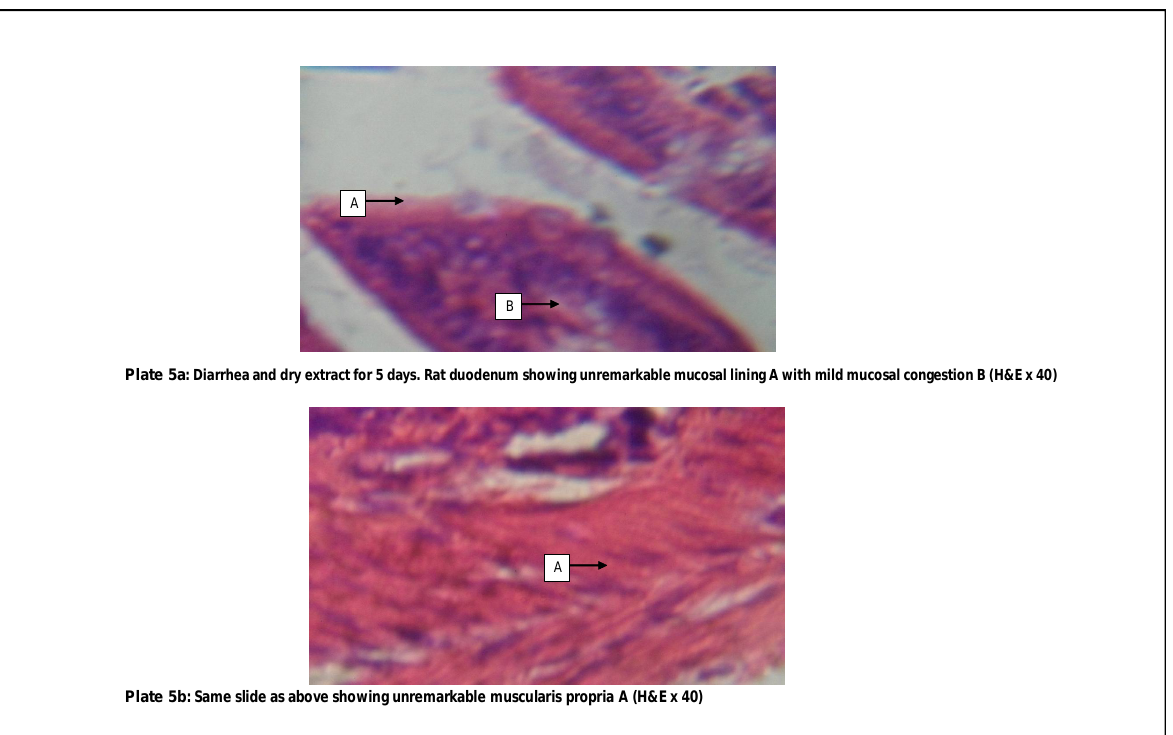
Plates B: Histology of the small intestine of lactose induced diarrheic rats treated with M.lucida